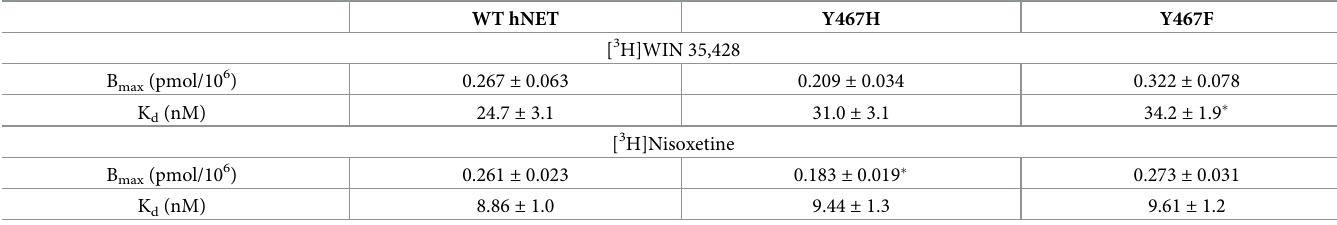
Table 2. Kinetic properties of [ 3 H] WIN35,428 and [ 3 H] Nisoxetine binding in PC12 cells expressing WT hNET and its mutants.